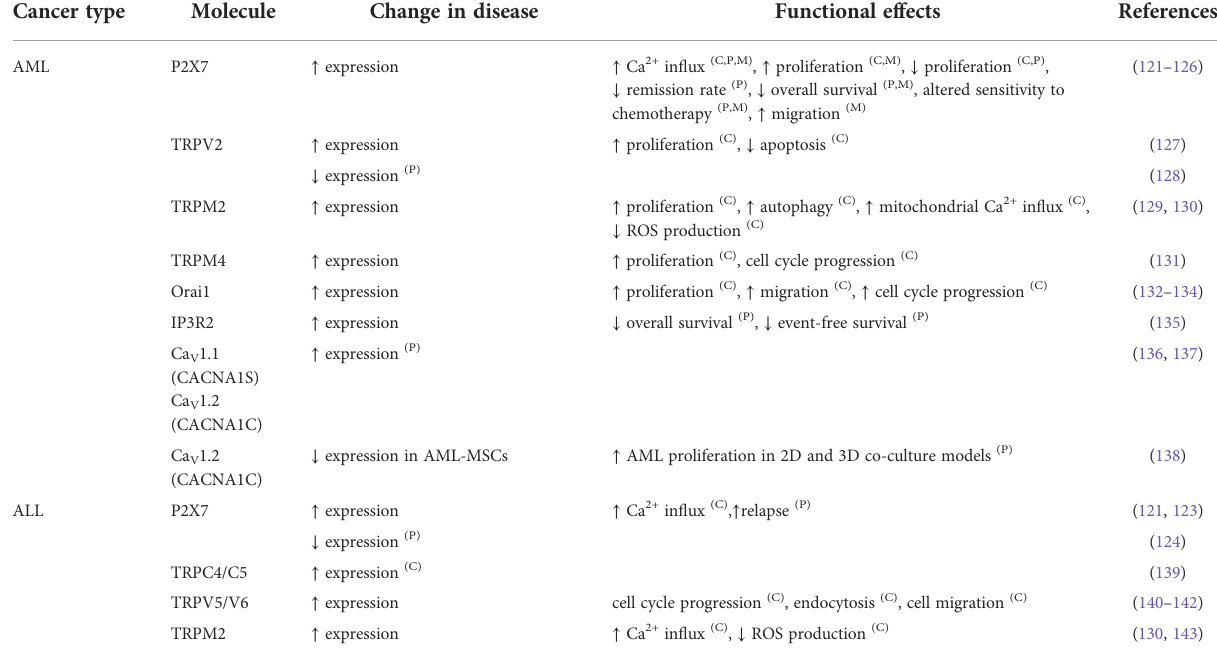
TABLE 1 The differential expression of plasma membrane calcium channels and their relative contribution to the malignant phenotype in different blood cancers. Cancer